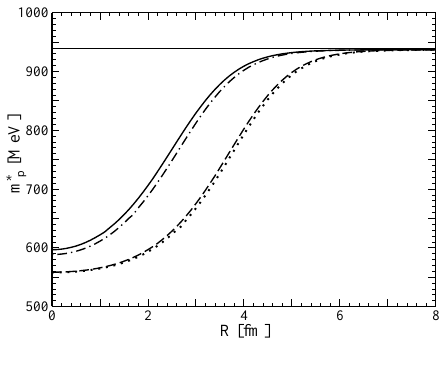
Fig. 2. The dependence of the e ff ective mass of the proton m ∗ on the distance R between the center of the skyrmion and the center of the nucleus. The solid curve represents the case that a skyrmion – quantized as a proton – is added to a 14 N nucleus, giving 15 O in total. The dot-dashed curve refers to the case of a 16 O nucleus 17 F in total. The dashed curve stands for the case → 39 Ca and the dotted curve represents the case of 40 Ca of 38 K → Sc. The horizontal line marks the free space value of the proton mass. Figure from Ref. [44].